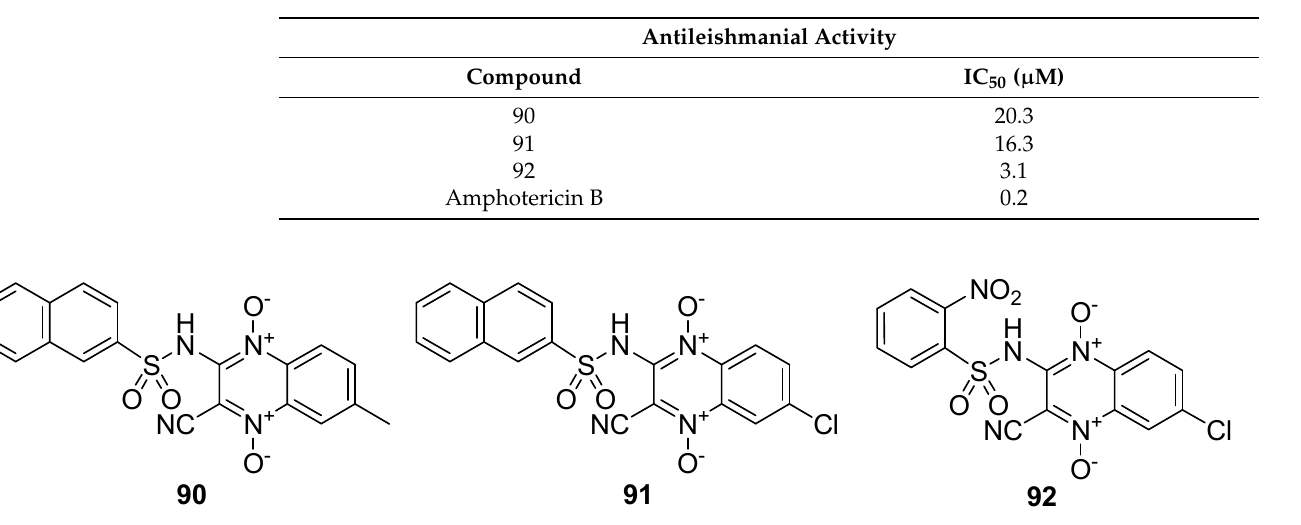
Table 8. Antileishmanial activity of quinoxaline-1,4-dioxide sulfonamide derivatives 90 – 92 .